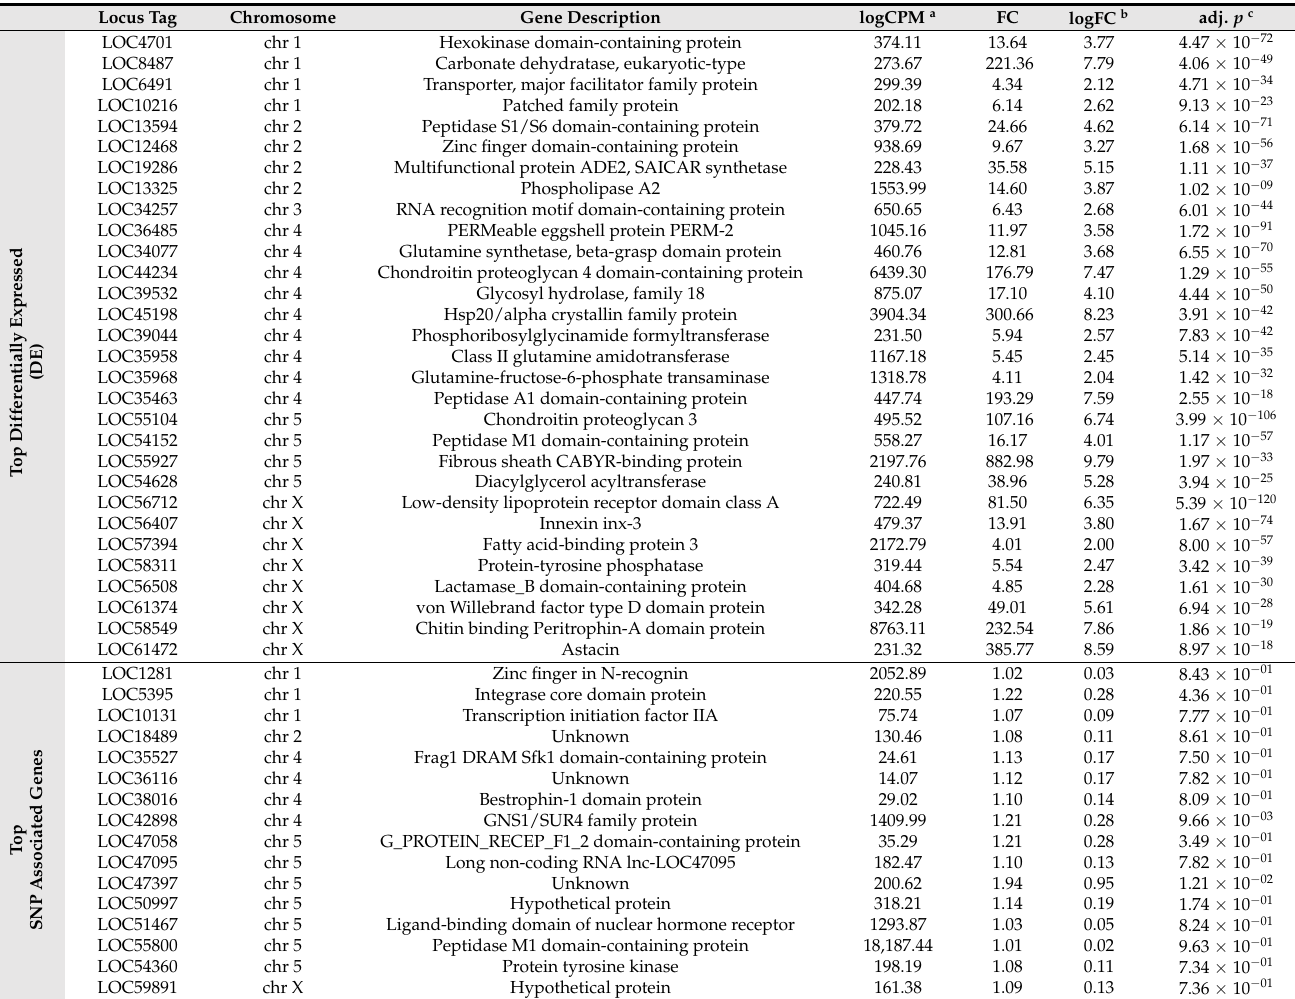
Table 2. Genome-wide SNP analysis using whole-genome sequencing of adult male H. contortus and the identified candidate genes putatively associated with vaccine